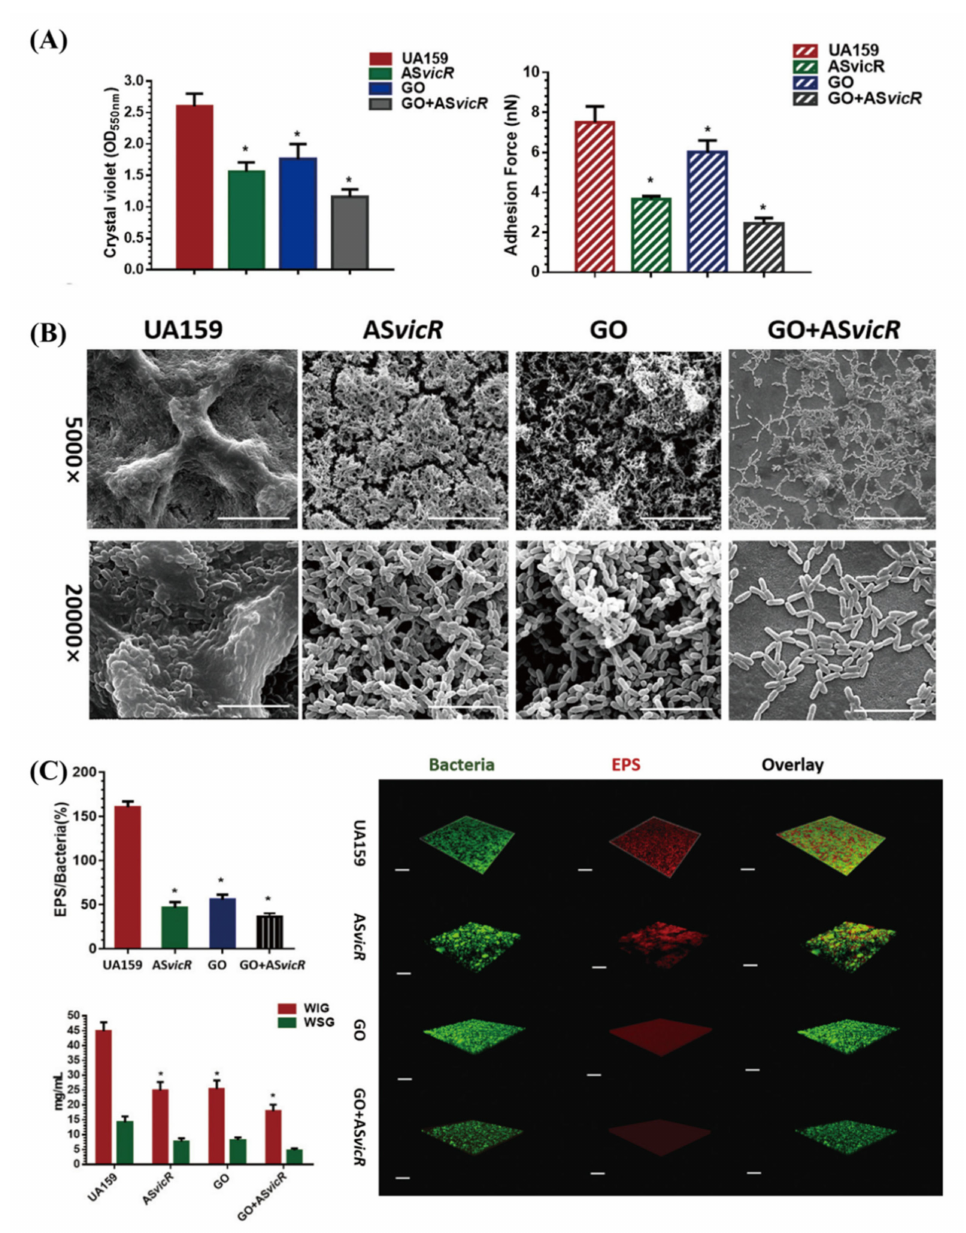
Figure 2. Nanographene oxide (GO) with antisense vicR (AsvicR) RNA inhibited the biofilm for- mation of Streptococcus mutans . ( A ) Biomass and the values of adhesion force of S. mutans biofilms; ( B ) SEM of S. mutans biofilms, scale bar for 5000 × /20,000 × magnification, 20 µ m/5 µ m; ( C ) volume ratio of the exopolysaccharide (EPS) matrix to the bacterial biomass in S. mutans biofilms, green for bacteria and red for the EPS matrix; scale bars, 100 µ m. * p < 0.05. [104] Copyright 2020, The Japanese Society for Dental Materials and